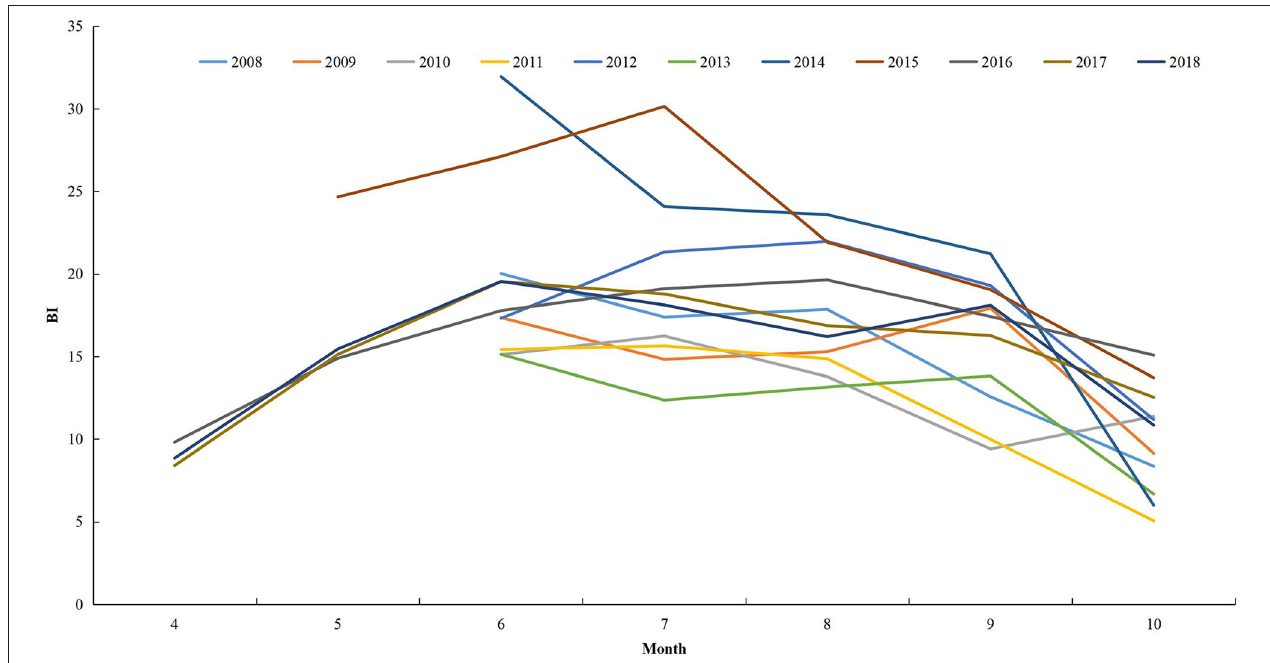
FIGURE 7 | The monthly mean Breteau Index in Zhejiang Province from 2008 to